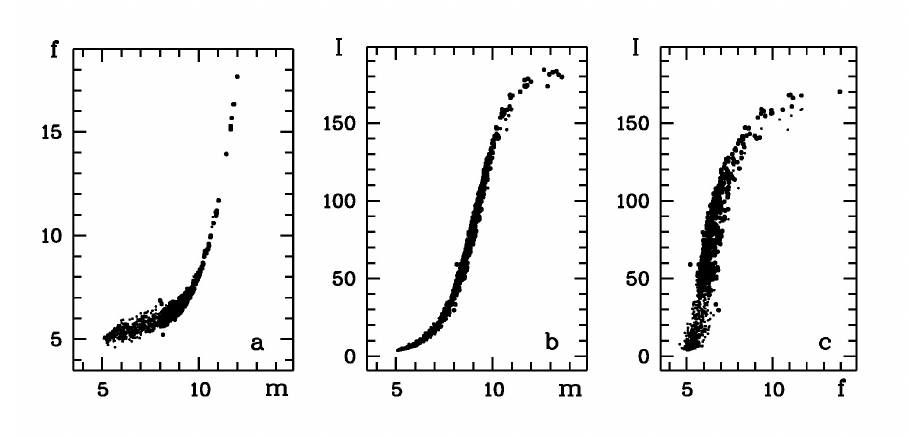
Figure 3. Functional connection of the instrumental photometric